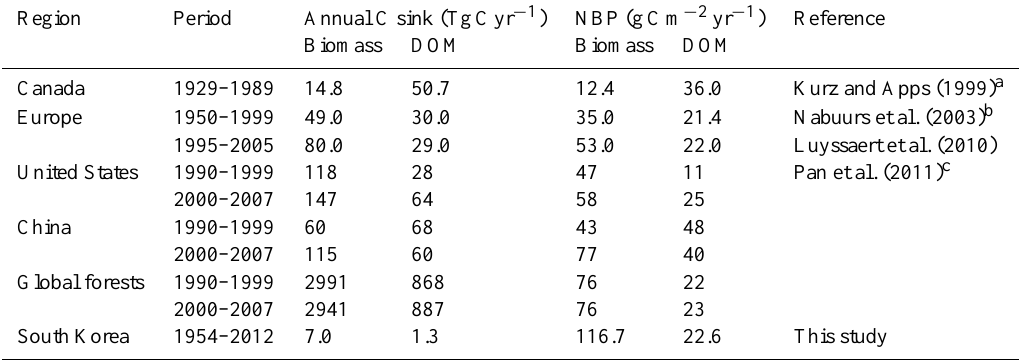
Table 3. The estimates of annual carbon (C) sink and net biome production (NBP) in South Korean forests compared to those in past studies from other countries.